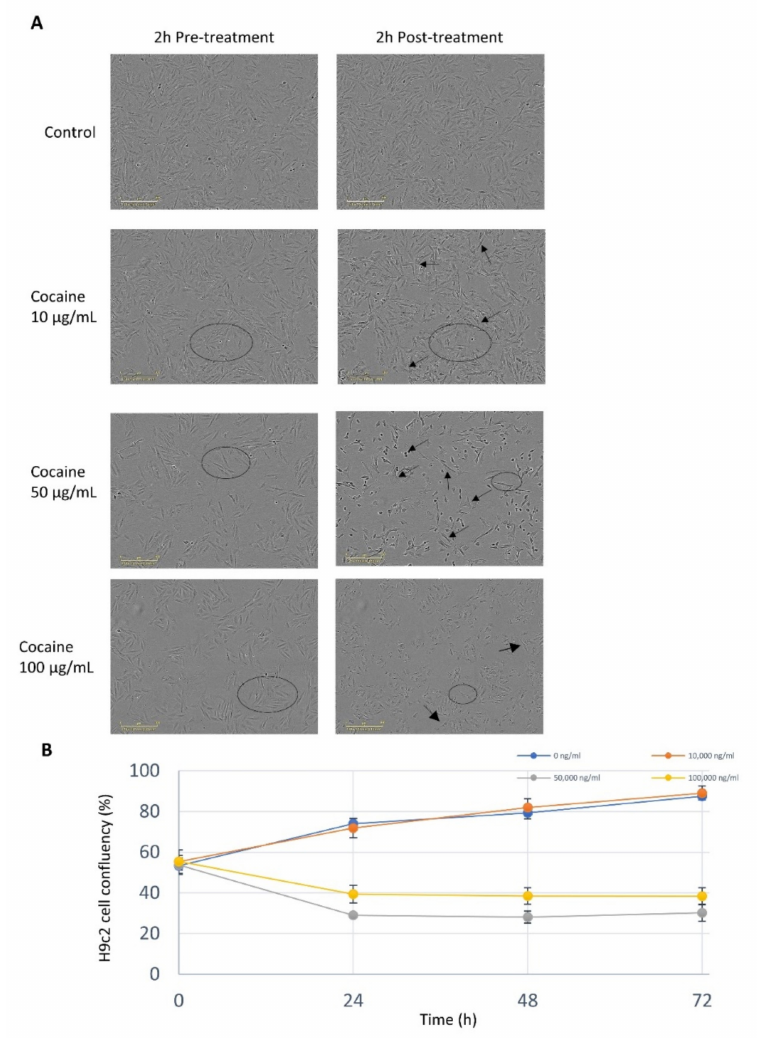
Figure 1. H9c2 cardiomyocyte morphology and cytotoxicity following cocaine exposure. ( A ) H9c2 cardiomyocytes indicated prominent stress features, including loss of compaction and cell—cell integrity after two-hour exposure at doses of 10–100 µ g/m (black circle and arrows, respectively). Images are representative of three independent experiments and were captured using IncuCyte Zoom®Live cell analyser (scale bar 300 µ m). ( B ) H9c2 cells treated with ranging low-to-high cocaine dose concentrations for 72 h without drug replacement. Data represents mean values ± SEM ( n = 24, for each data point on a 96—well transparent culture plate recorded from three independent experiments). Statistical comparison was performed by a one-way ANOVA followed by the post hoc Dunnent’s comparison test, * p < 0.05 for each group vs